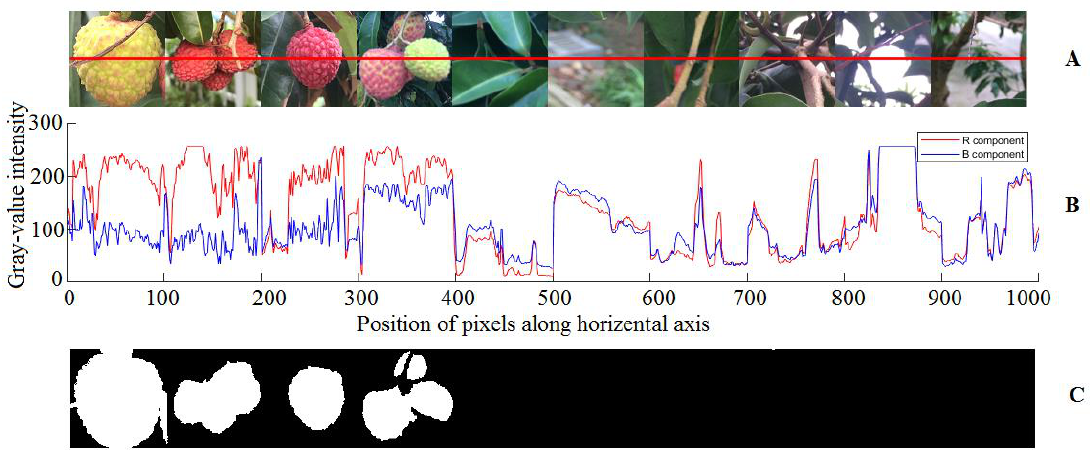
Figure 5. RGB color component statistics of lychees, immature lychees and background. ( A ) Example diagrams and sample red line. ( B ) The R and B component curves corresponding to the sampling red line. ( C ) Results of R-B chromatic mapping with morphological algorithm.